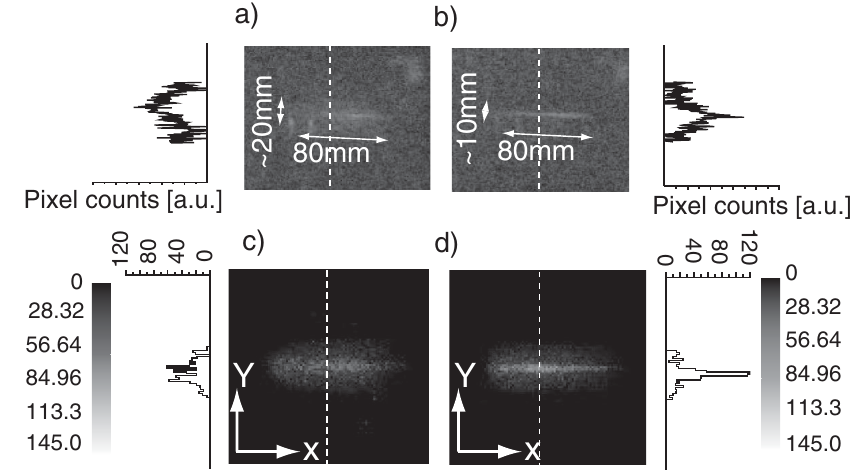
FIG. 3. Transverse bunch profiles without slit obtained with the LSBPM unit when rf is on (a) and off (b) at plane ‘‘f’’. Those predicted by the PARMILA simulation when rf is on (c) and off (d) on the same scale. The line graphs beside the panels show the vertical projections of each image. The x and y axes in the figure correspond to those in Fig. 1.